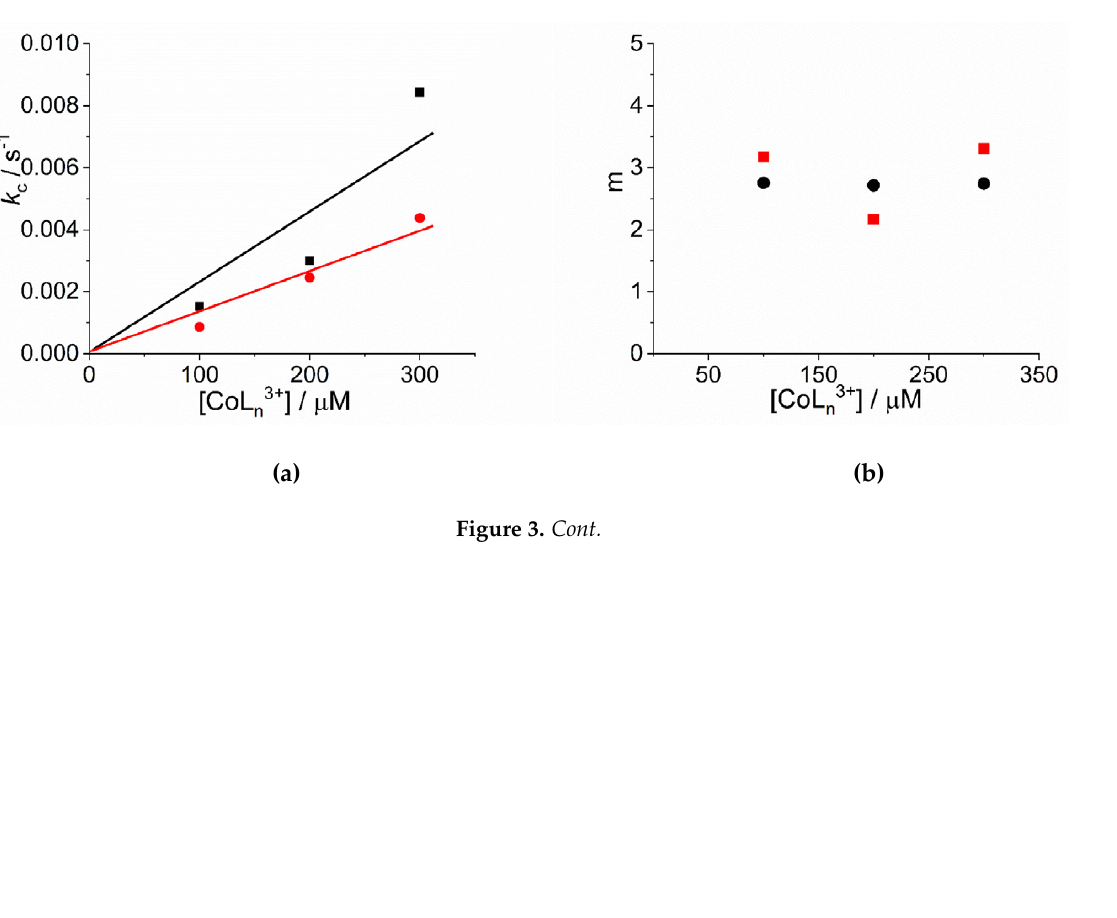
from non-linear fit of extinction data to eq. 1 at 490 nm. In most of the examined cases, the term k 0 makes a statistically irrelevant contribution to the overall